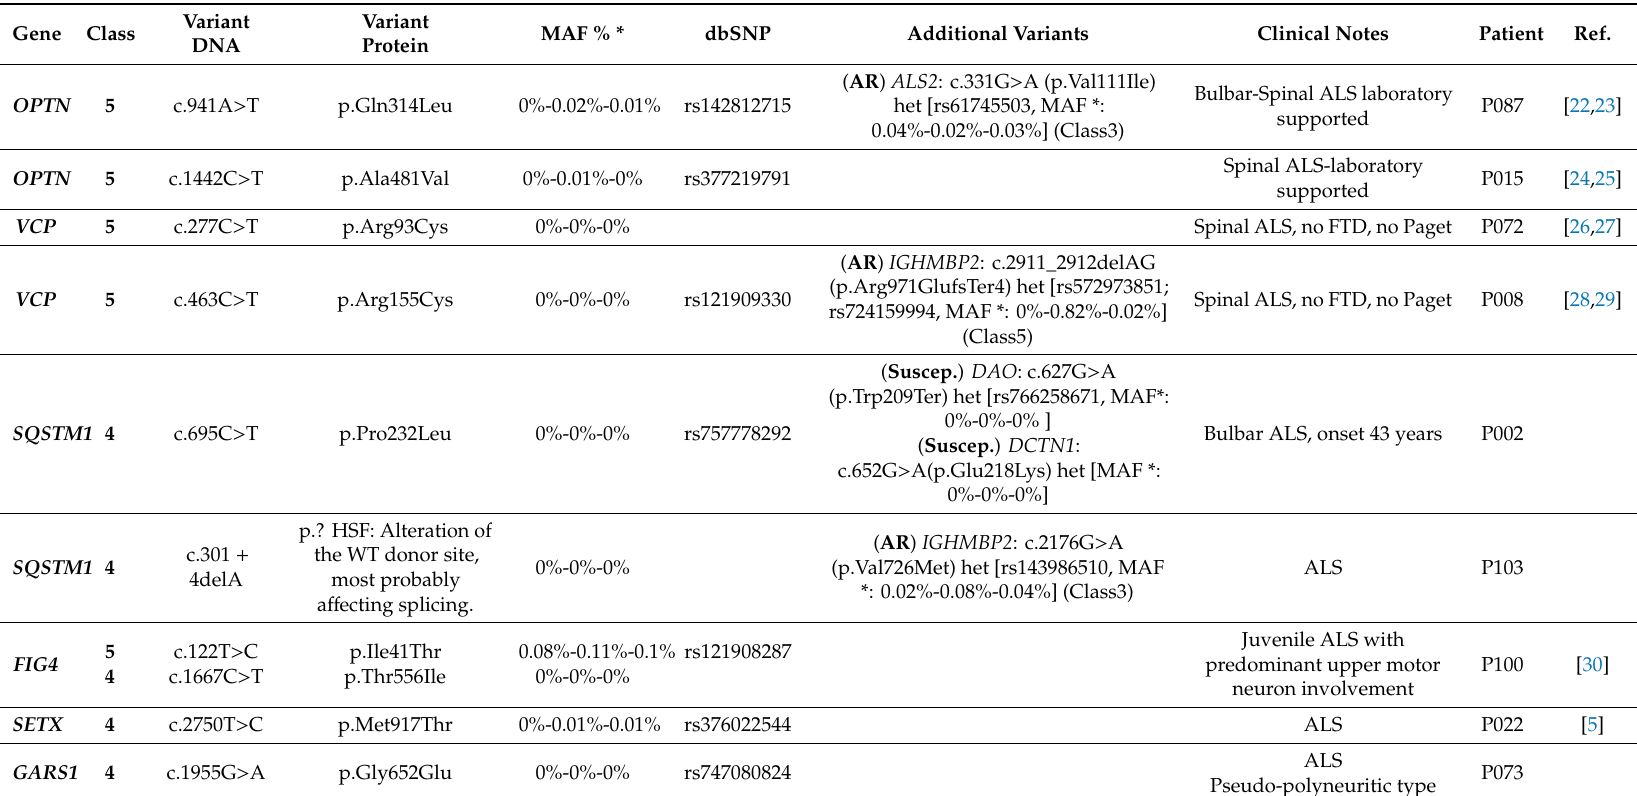
Table 4. Pathogenic and likely pathogenic variants in ALS genes (Classes 4 and